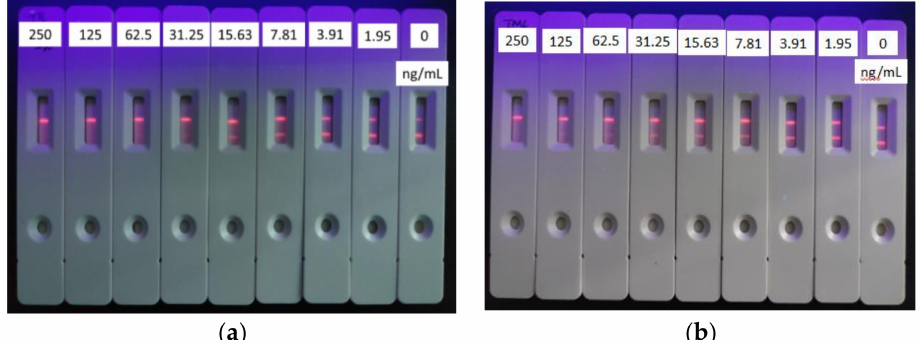
Figure 11. Standard curves for tylosin ( a ) and tilmicosin ( b ) in milk using TRFICA ( n = 3).